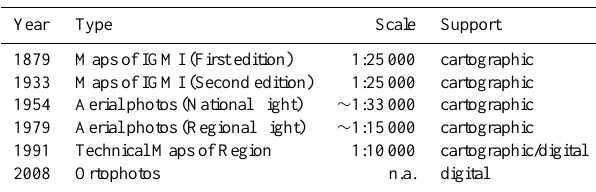
Table 2. Map and aerial photography data sets for the study area. n.a.=not available.